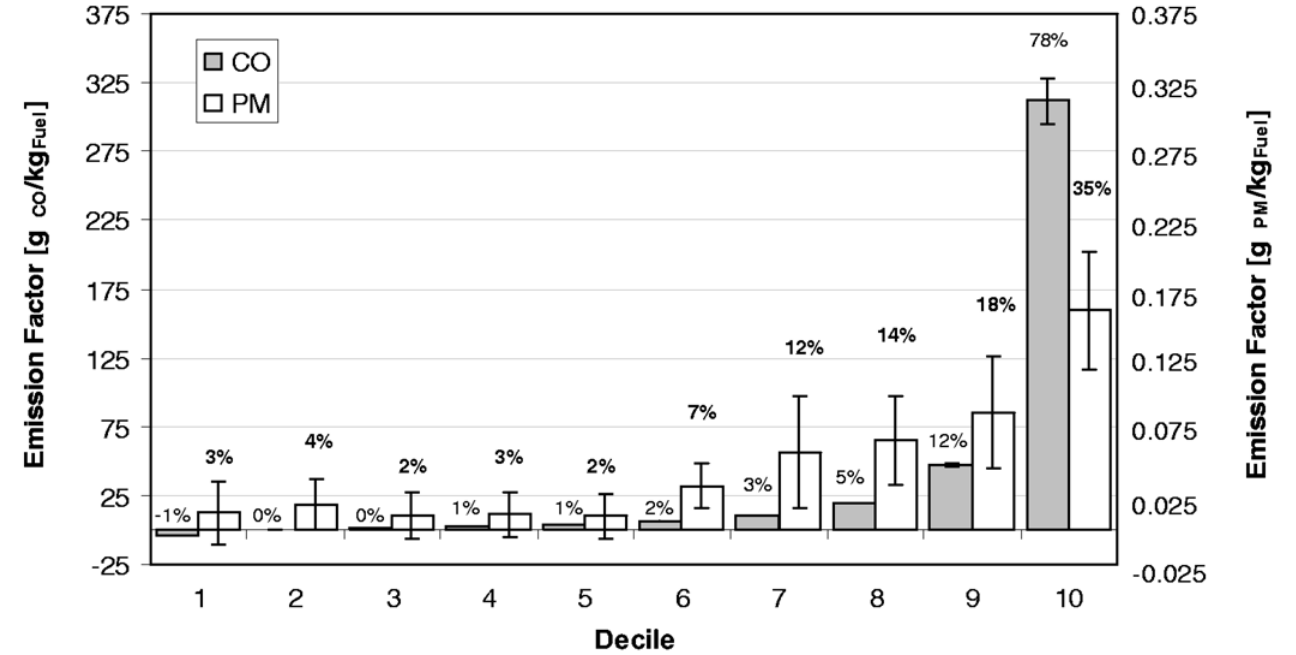
Figure 11. Contributions of lowest to highest CO emitters to the CO and PM emission factors for spark-ignition vehicles measured in Las Vegas in 2002. The error bars represent the 95% confidence interval for the respective decile mean. The percent above each column indicates the contribution to the fleet emission factor of CO or PM